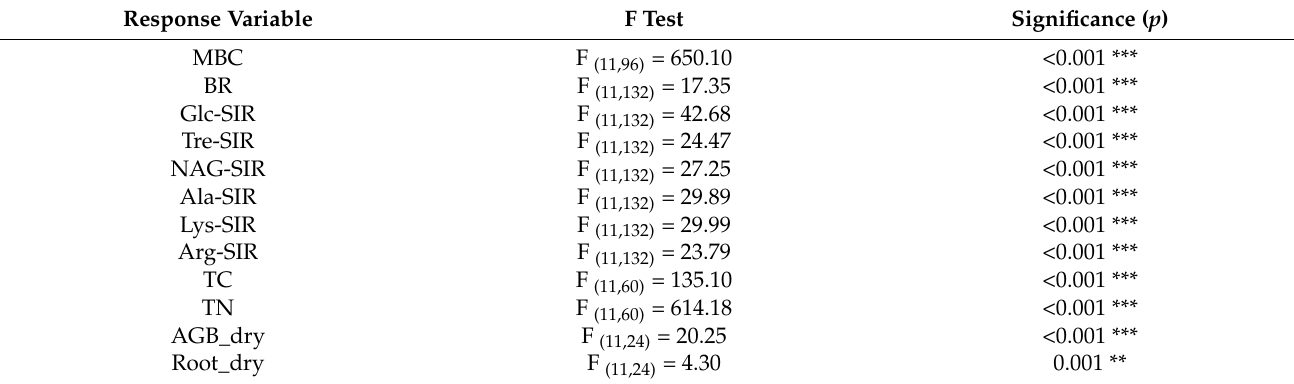
Table A1. Detailed results after multivariate analysis of variance MANOVA (ANOVA separately). Response